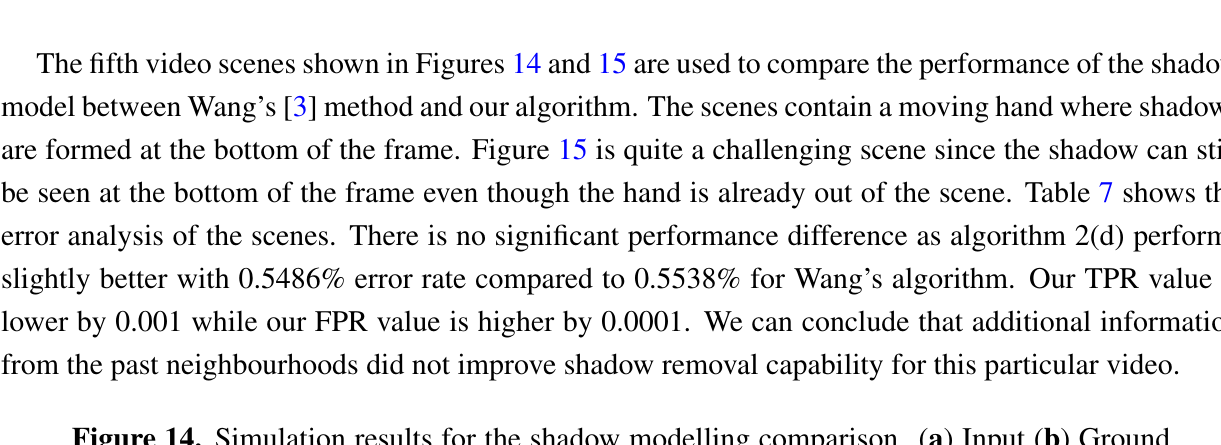
Figure 14. Simulation results for the shadow modelling comparison. ( a ) Input ( b ) Ground truth ( c ) Method: Wang ( d ) Method: Zulkifley et al .